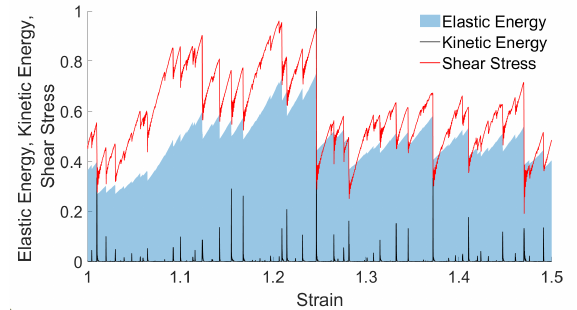
Figure 2. Evidence of macroscopic stick-slip.